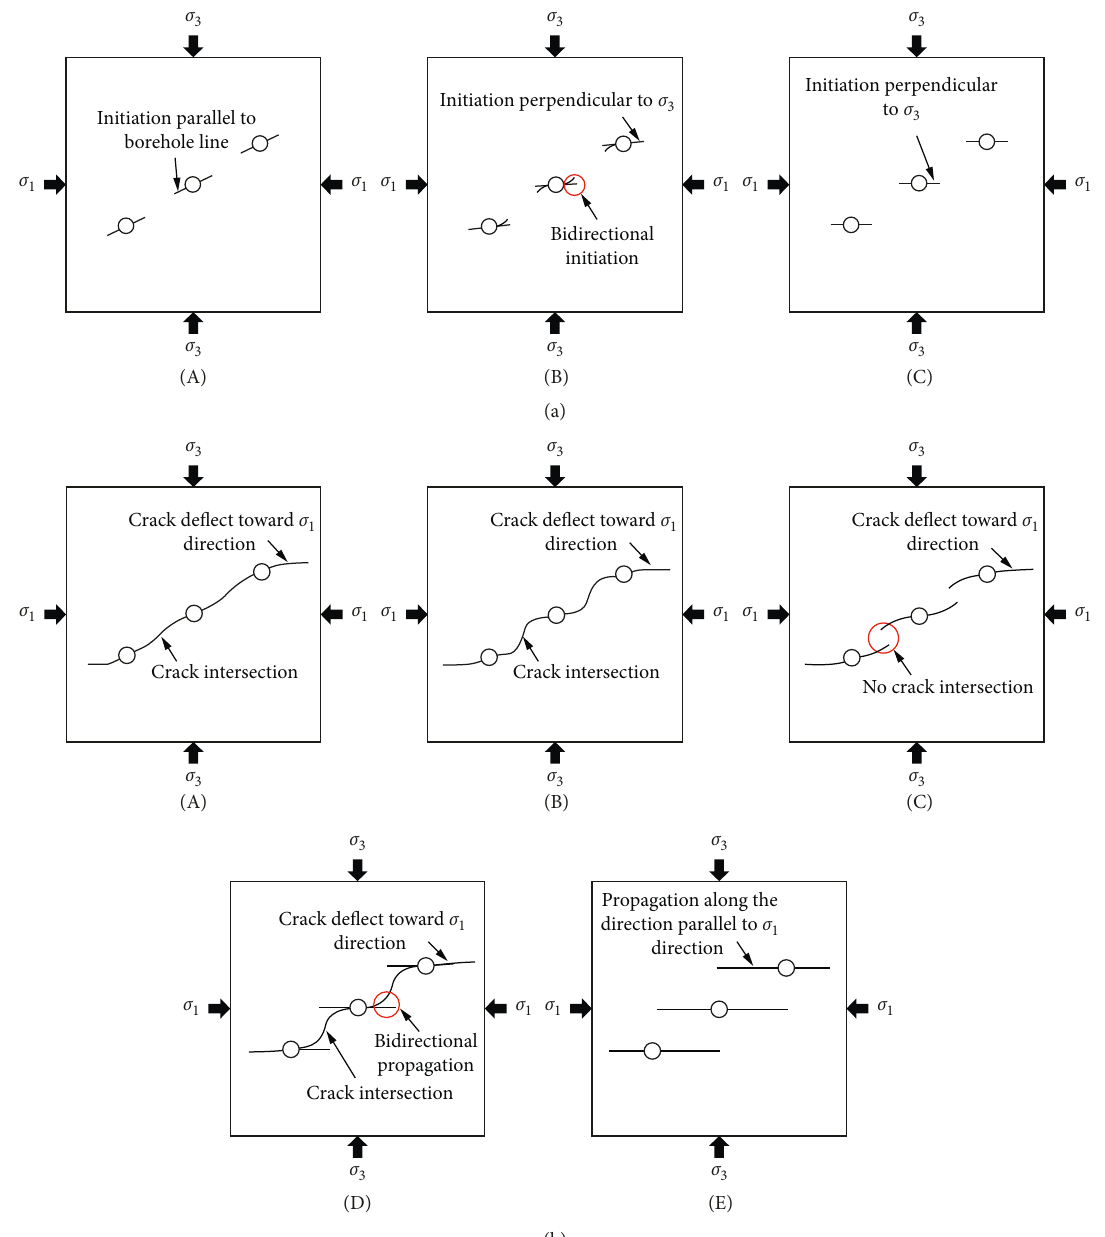
Figure 12: Crack initiation and propagation modes of directional hydraulic fracturing controlled by dense linear multihole drilling. (a) Three modes of crack initiation of directional hydraulic fracturing controlled by dense linear multihole drilling. (A) Initiation along the borehole line. (B) Bidirectional initiation. (C) Initiation perpendicular to σ 3 . (b) Five modes of crack propagation of directional hydraulic fracturing controlled by dense linear multihole drilling. (A) Propagation along borehole line. (B) Propagation forming ladder pattern. (C) Propagation forming S-shaped pattern. (D) Bidirectional propagation. (E) Propagation perpendicular to σ